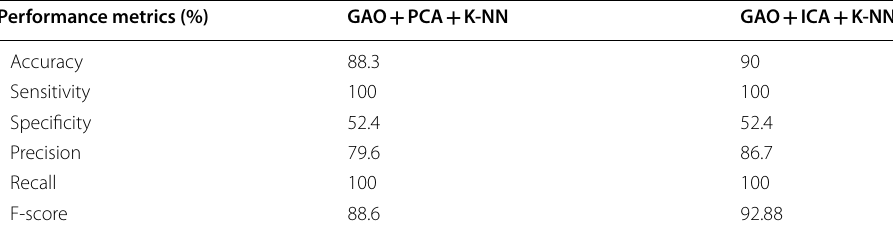
ICA K-NN TP 39; TN 15; FP 6; FN 0 + + = = = = PCA K-NN and GAO + + PCA K‑NN GAO + +